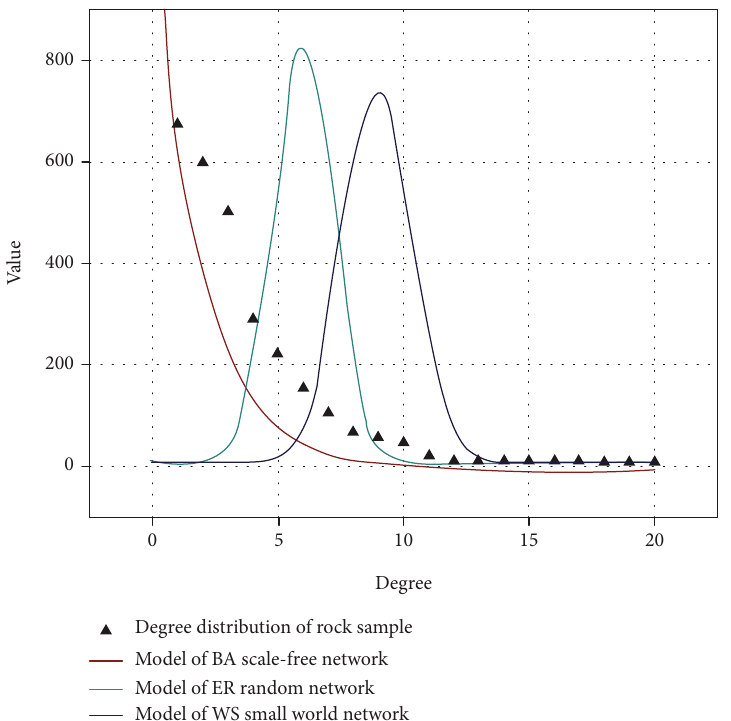
Figure 3: Comparison of di ff erent models with real-rock distribution characteristics (note: the degree distribution of regular model is the points of degree = 2 , 3, 4, and